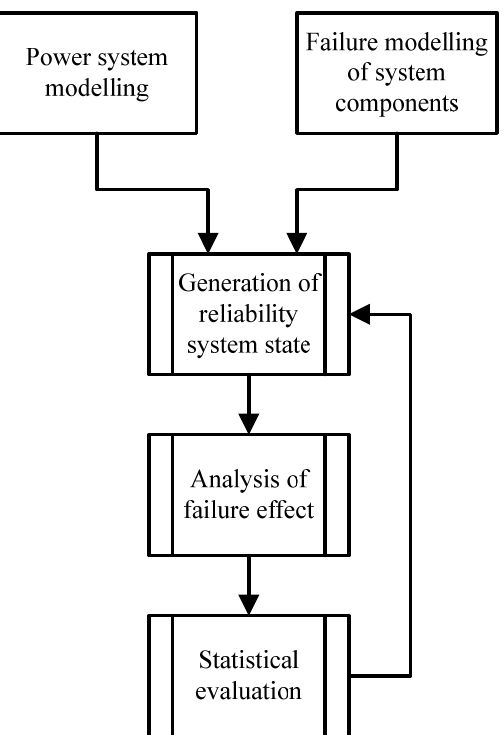
Figure 3. Flow diagram of the reliability assessment in PF software.